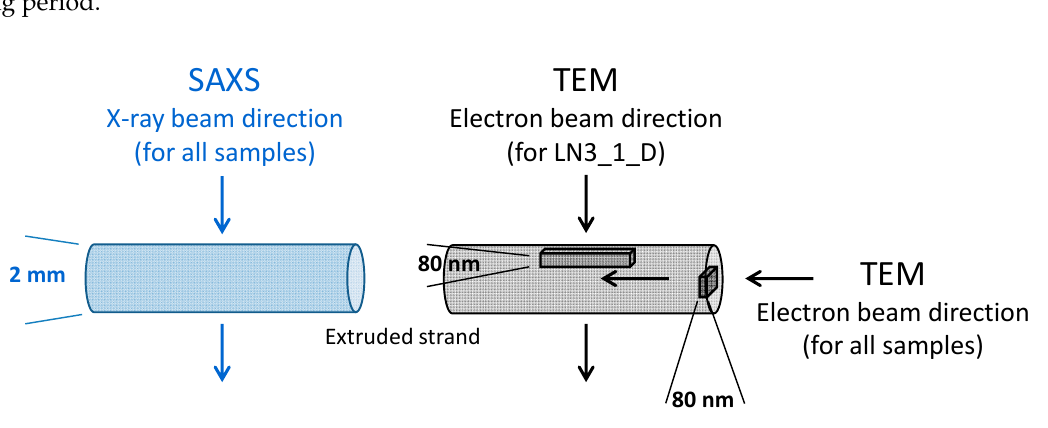
Figure 1. Sample preparation and beam direction in small-angle X-ray scattering (SAXS) and transmission electron microscopy (TEM) analysis .